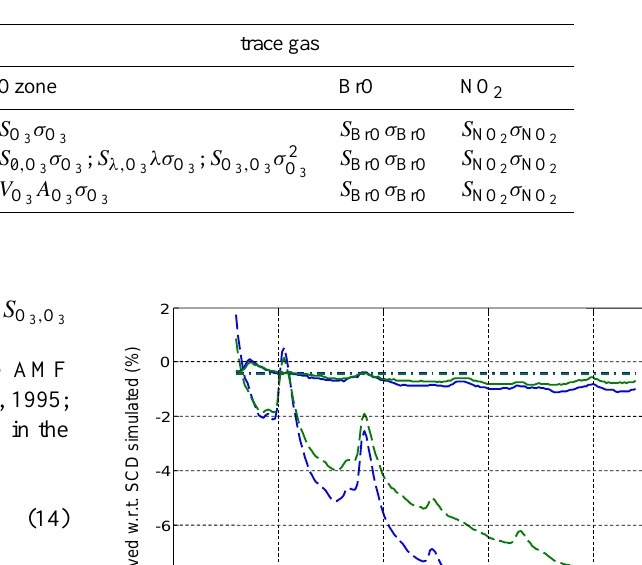
Table 4. Fit terms describing the trace gas absorptions for different approaches in the DOAS fit.